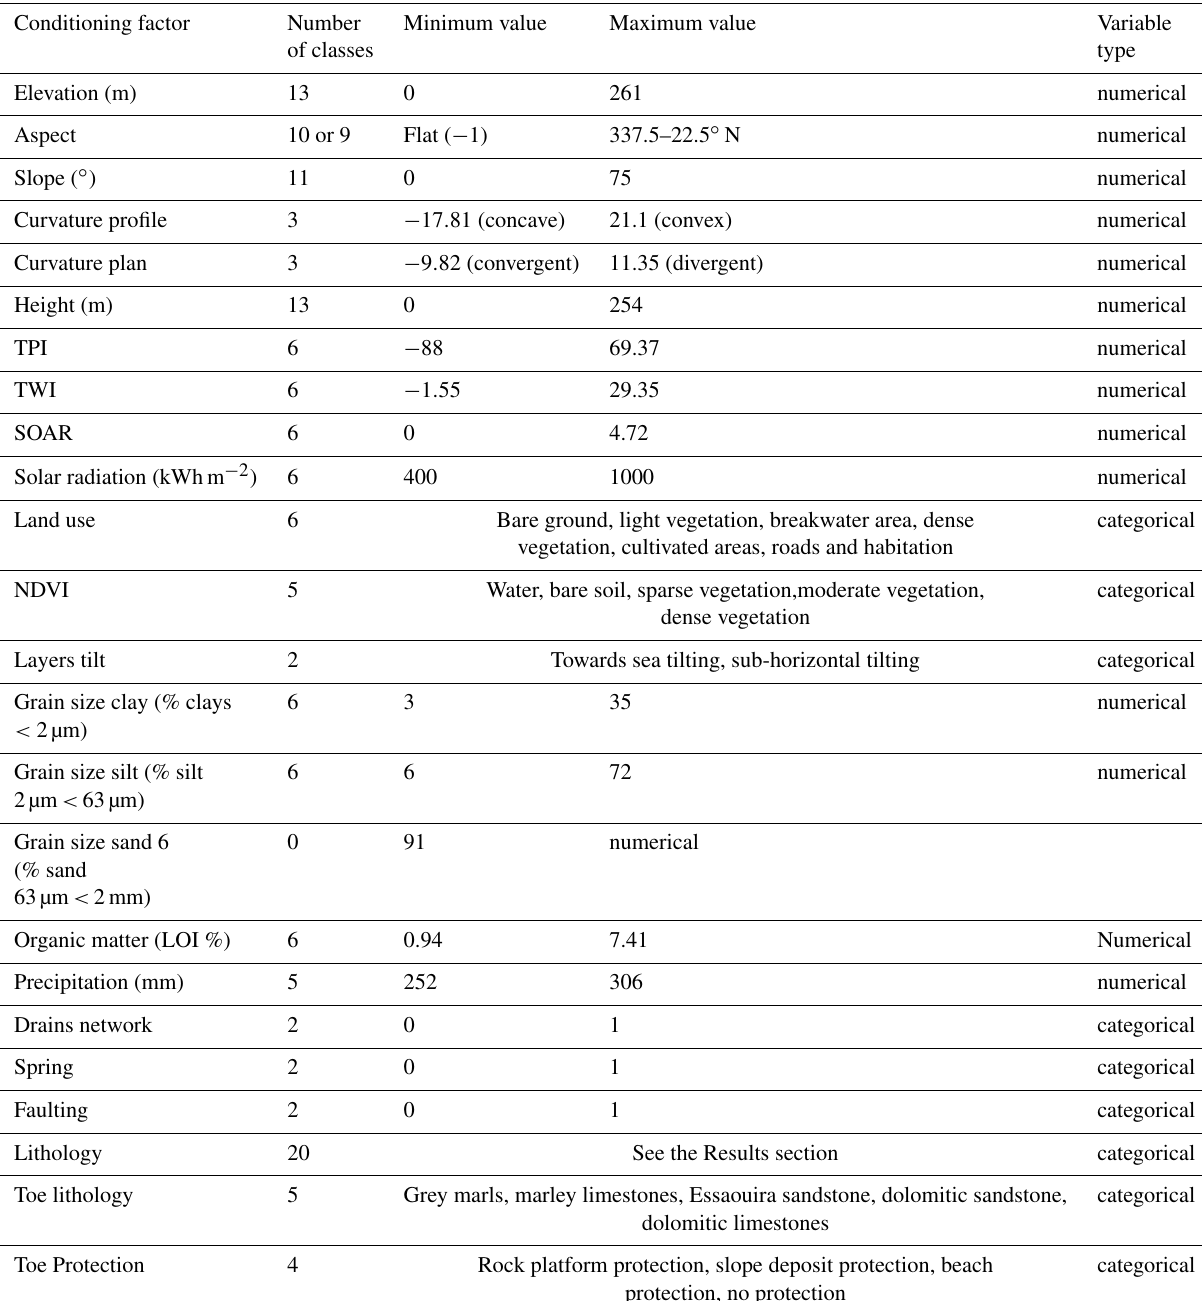
Table 2. Input conditioning